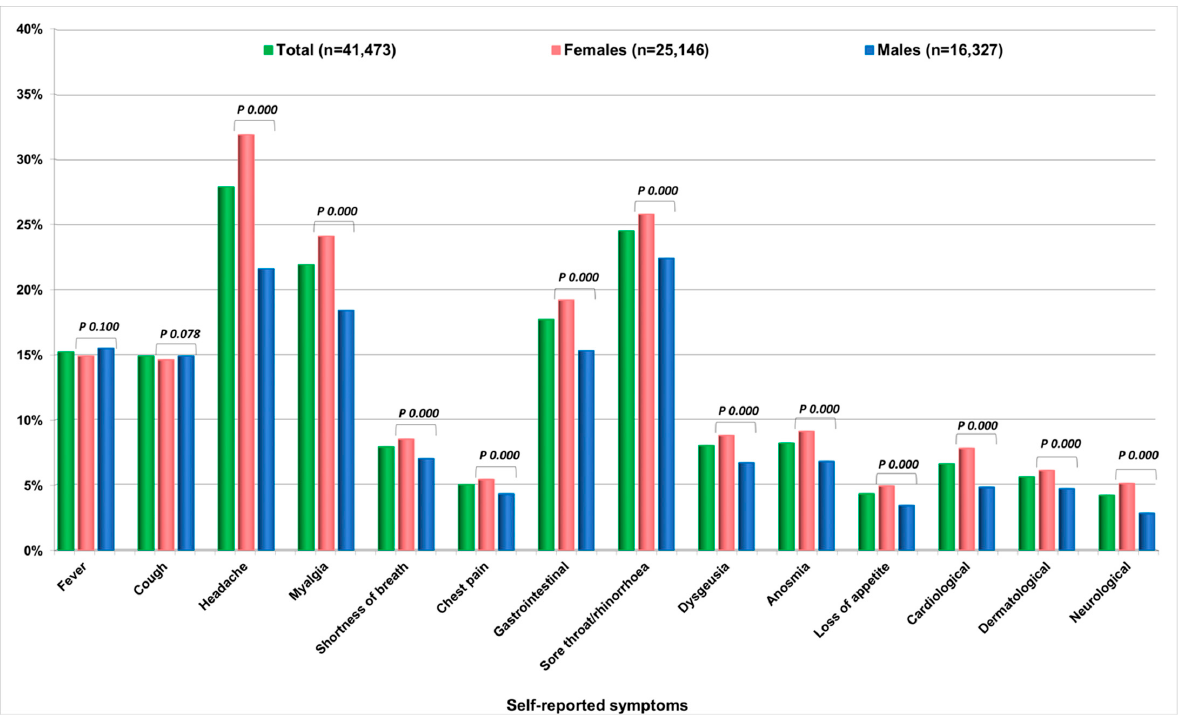
Figure 3. Frequency of self-reported symptoms by sex between March 2020 and February 2021 ( n = 41,473) and p -values of the comparisons between females and males.